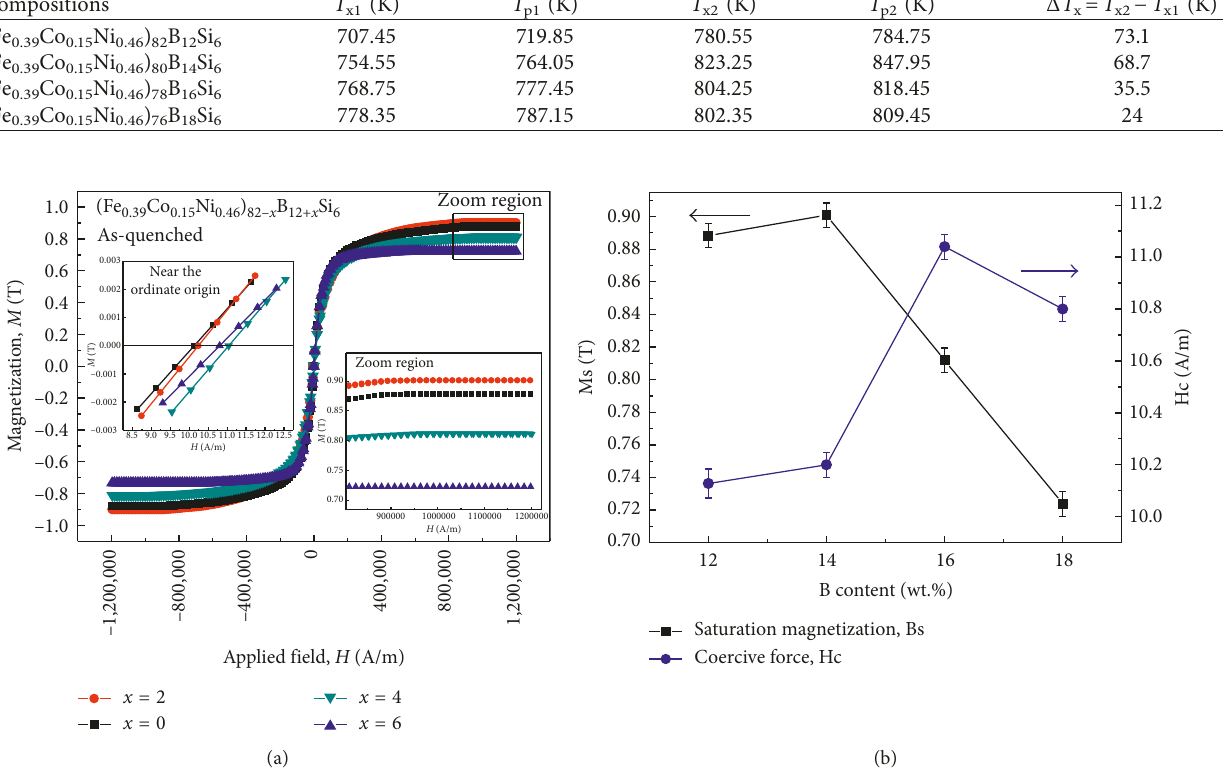
Figure 4: B-content dependence of magnetic hysteresis loop (a) and Ms and Hc (b) for as-quenched (Fe 4, and 6)